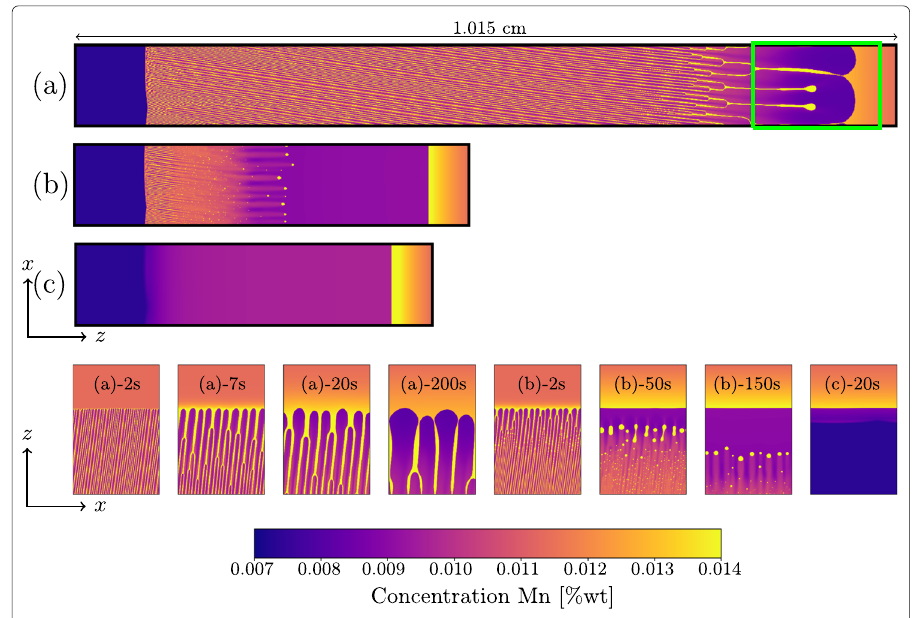
Fig. 4 Top: Spatiotemporal plot at 400 s of the Mn-concentration field for case (a) G = 1 Kcm − 1 and V pull = 2 μ ms − 1 , (b) G = 4 Kcm − 1 and V pull = 6 μ ms − 1 , (c) G = 10 Kcm − 1 and V pull = 8 μ ms − 1 . The green rectangle represents the size of the moving calculation domain. Bottom: Mn-concentration field in the simulation domain for case (a) at 2 s, 7 s, 20 s, 200 s; for case (b) at 50 s and 150 s; for case (c) at 20